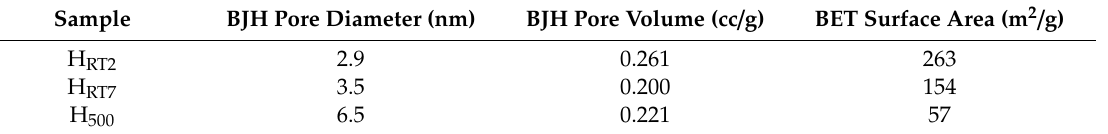
Table 3. Specific surface areas obtained by the BET equation fit for N 2 gas adsorption isotherms of the samples of hematite obtained from two and seven months of aging at RT and from calcination at 500 °C. Pore diameters and pore volume from BJH analysis are also reported.